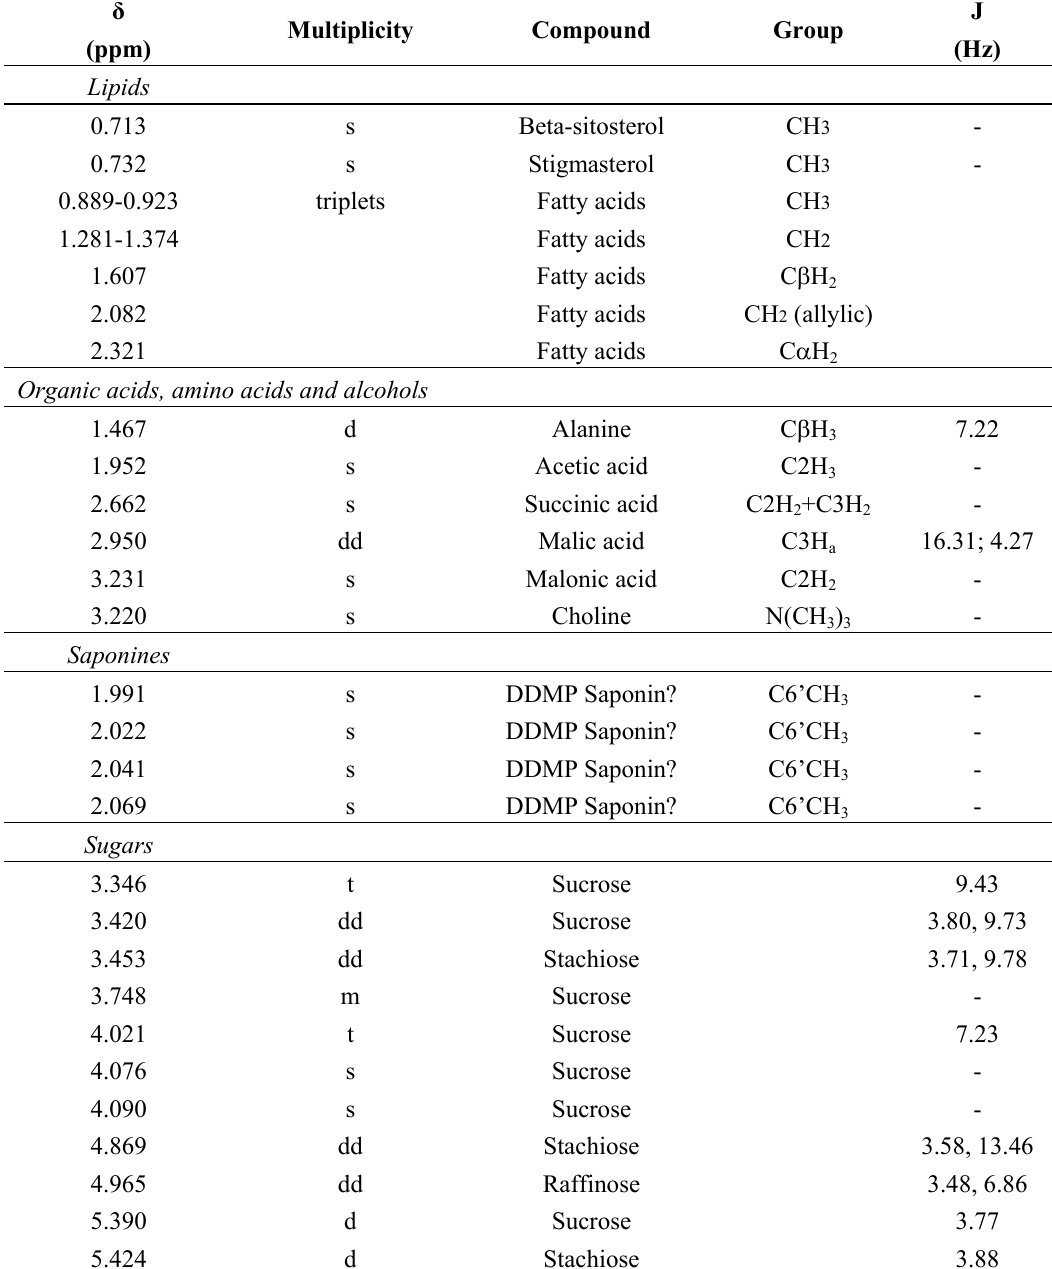
Table 1. Characteristics of 1H NMR signals observable in the zone 1-9 ppm of soybean methanolic